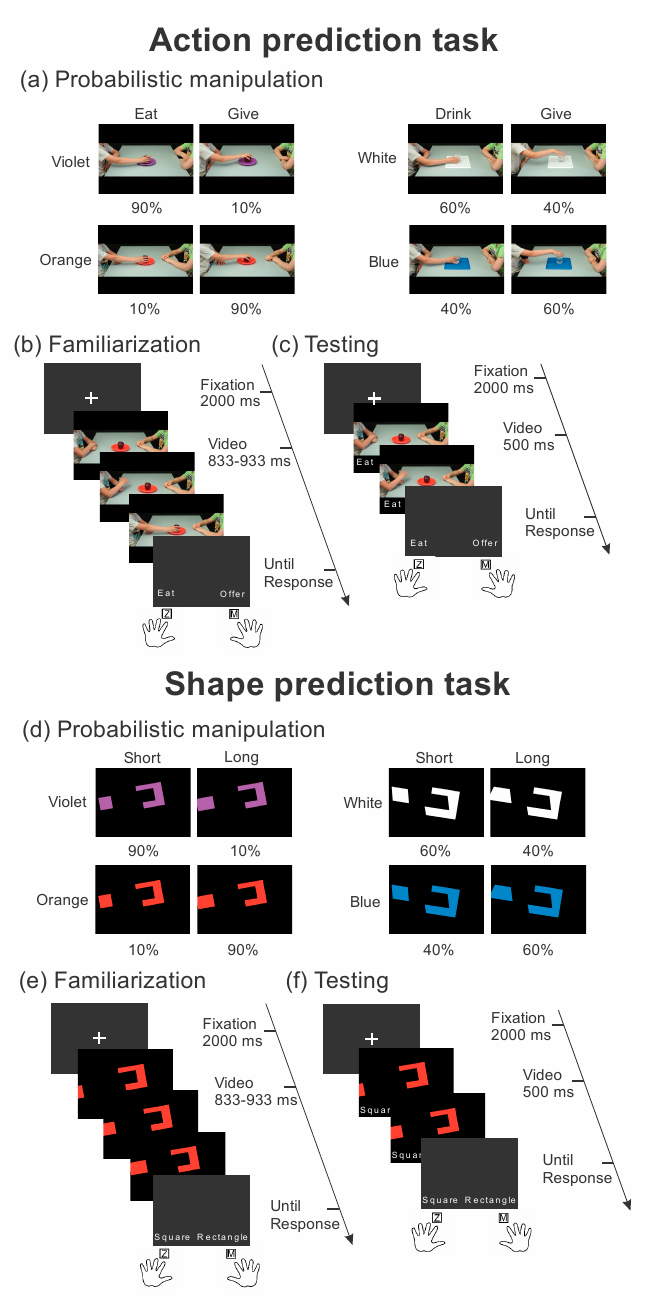
Figure 1. Stimuli and Experimental tasks. Action prediction task: ( a ) sketch of probabilities manipulation for the familiarization phase. Action-context associations were manipulated in terms of their probability of co-occurrence to 90%, 10%, 60%, and 40%; ( b ) familiarization phase showing videos of a child performing individual or interpersonal actions. Participants had to predict action unfolding; ( c ) testing phase showing the same videos during familiarization but of shortened duration. Participants had to predict action unfolding, as during the familiarization phase. Shape prediction task; ( d ) sketch of probabilities manipulation for the familiarization phase. Shapes-context associations were manipulated in terms of their probability of co-occurrence to 90%, 10%, 60% and 40%; ( e ) familiarization phase showing videos of moving shapes approaching the receptor shape. Participants had to predict shape identity; ( f ) testing phase showing the same videos during familiarization but of shortened duration. Participants had to predict shape identity, as during the familiarization